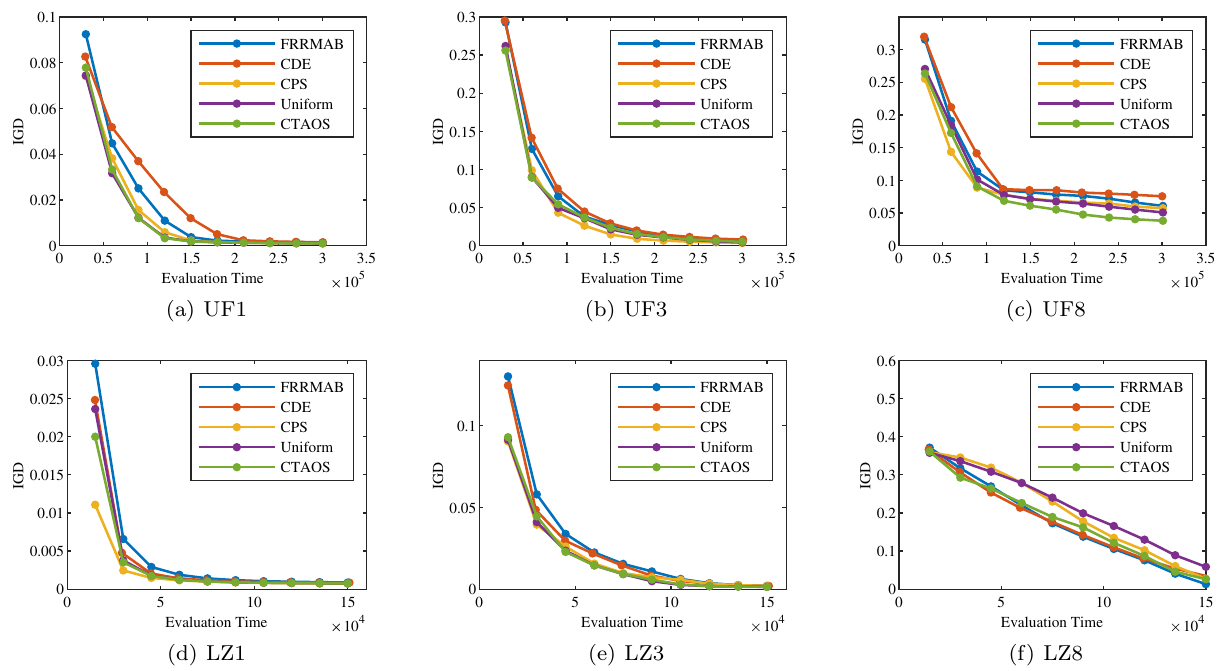
Fig. 6 The average IGD values in 30 runs produced by five MOEAs with different AOS methods at each time point